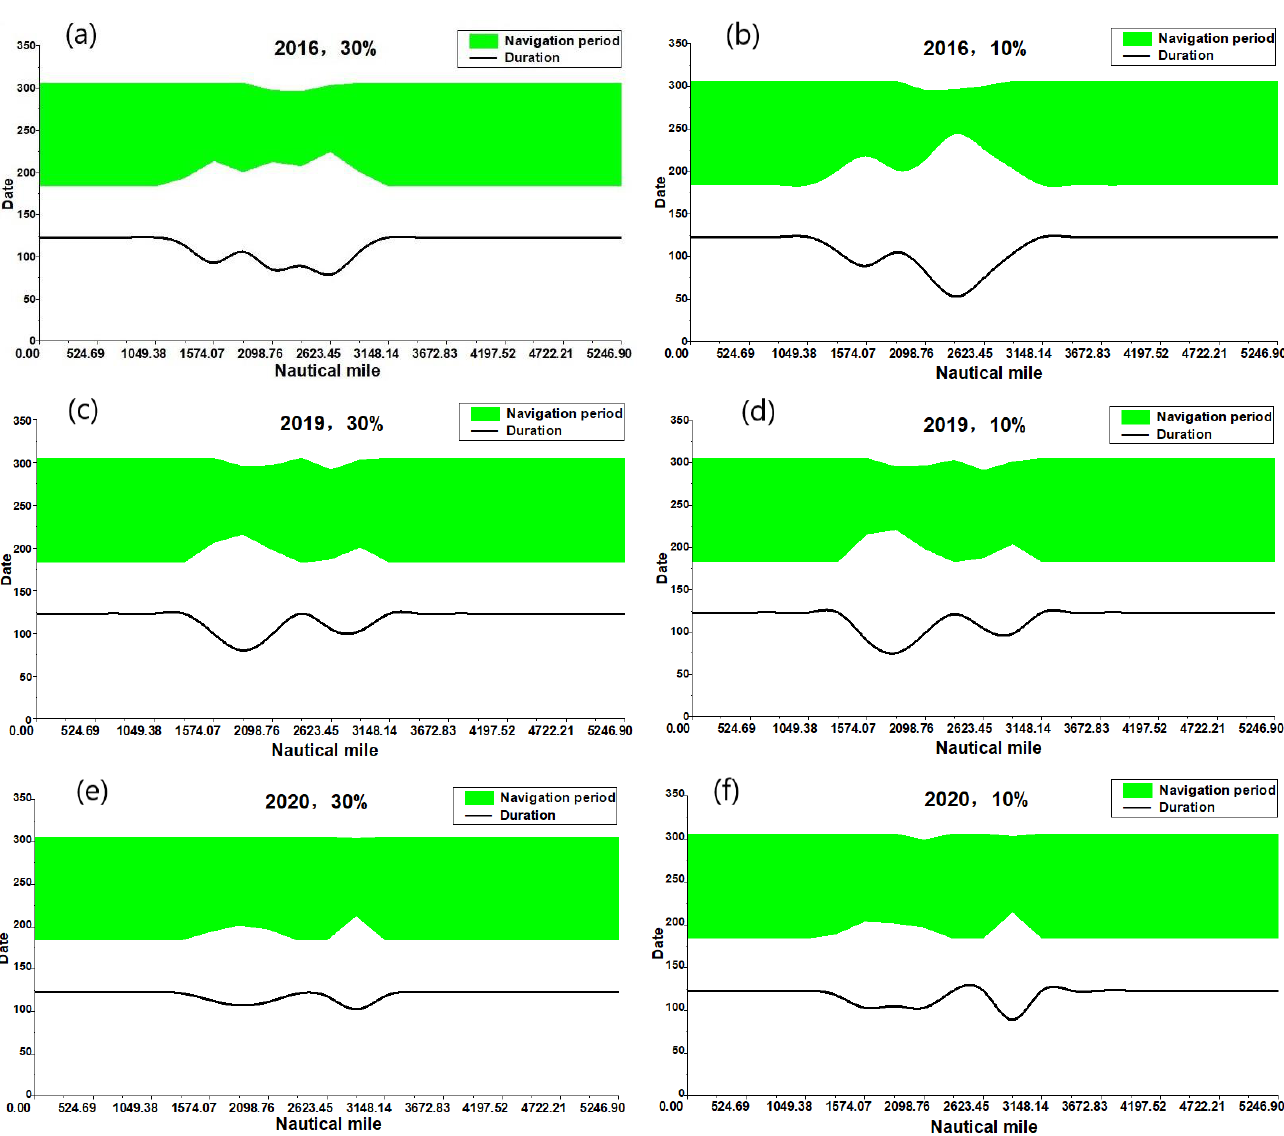
Figure 11. Navigation status of the Arctic NEP in 2016, 2019 and 2020. (The abscissa is the location of the NEP, and the ordinate is the date of the year in the NEP, the green area indicates the navigable period of the NEP in the current year, and the solid black line indicates the navigable duration of the navigable channel in the current year).